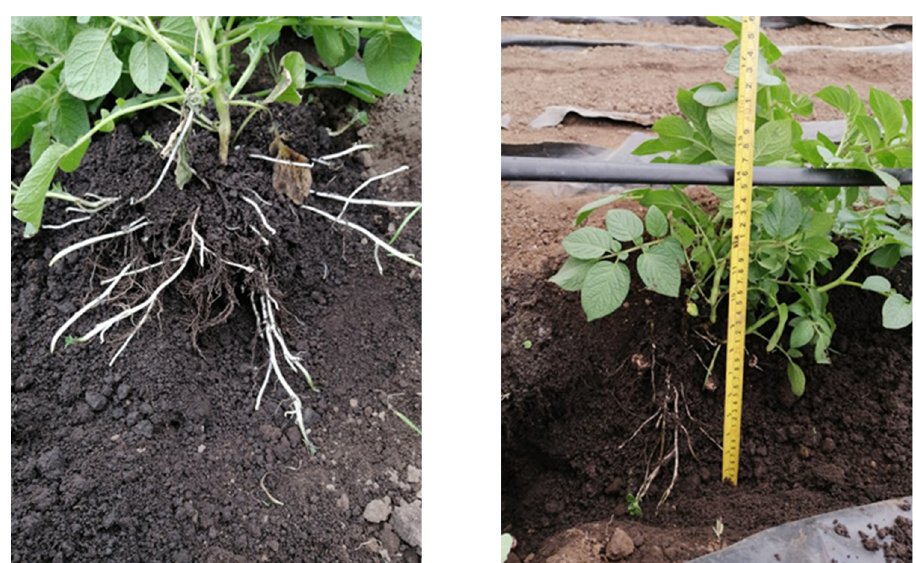
Figure A1. Tubers differentiation stage: left and right photographs show the development of stolons: at the apex, “hook” and “matchstick” forms, these are morphological changes in the stolons in the tuber differentiation process.